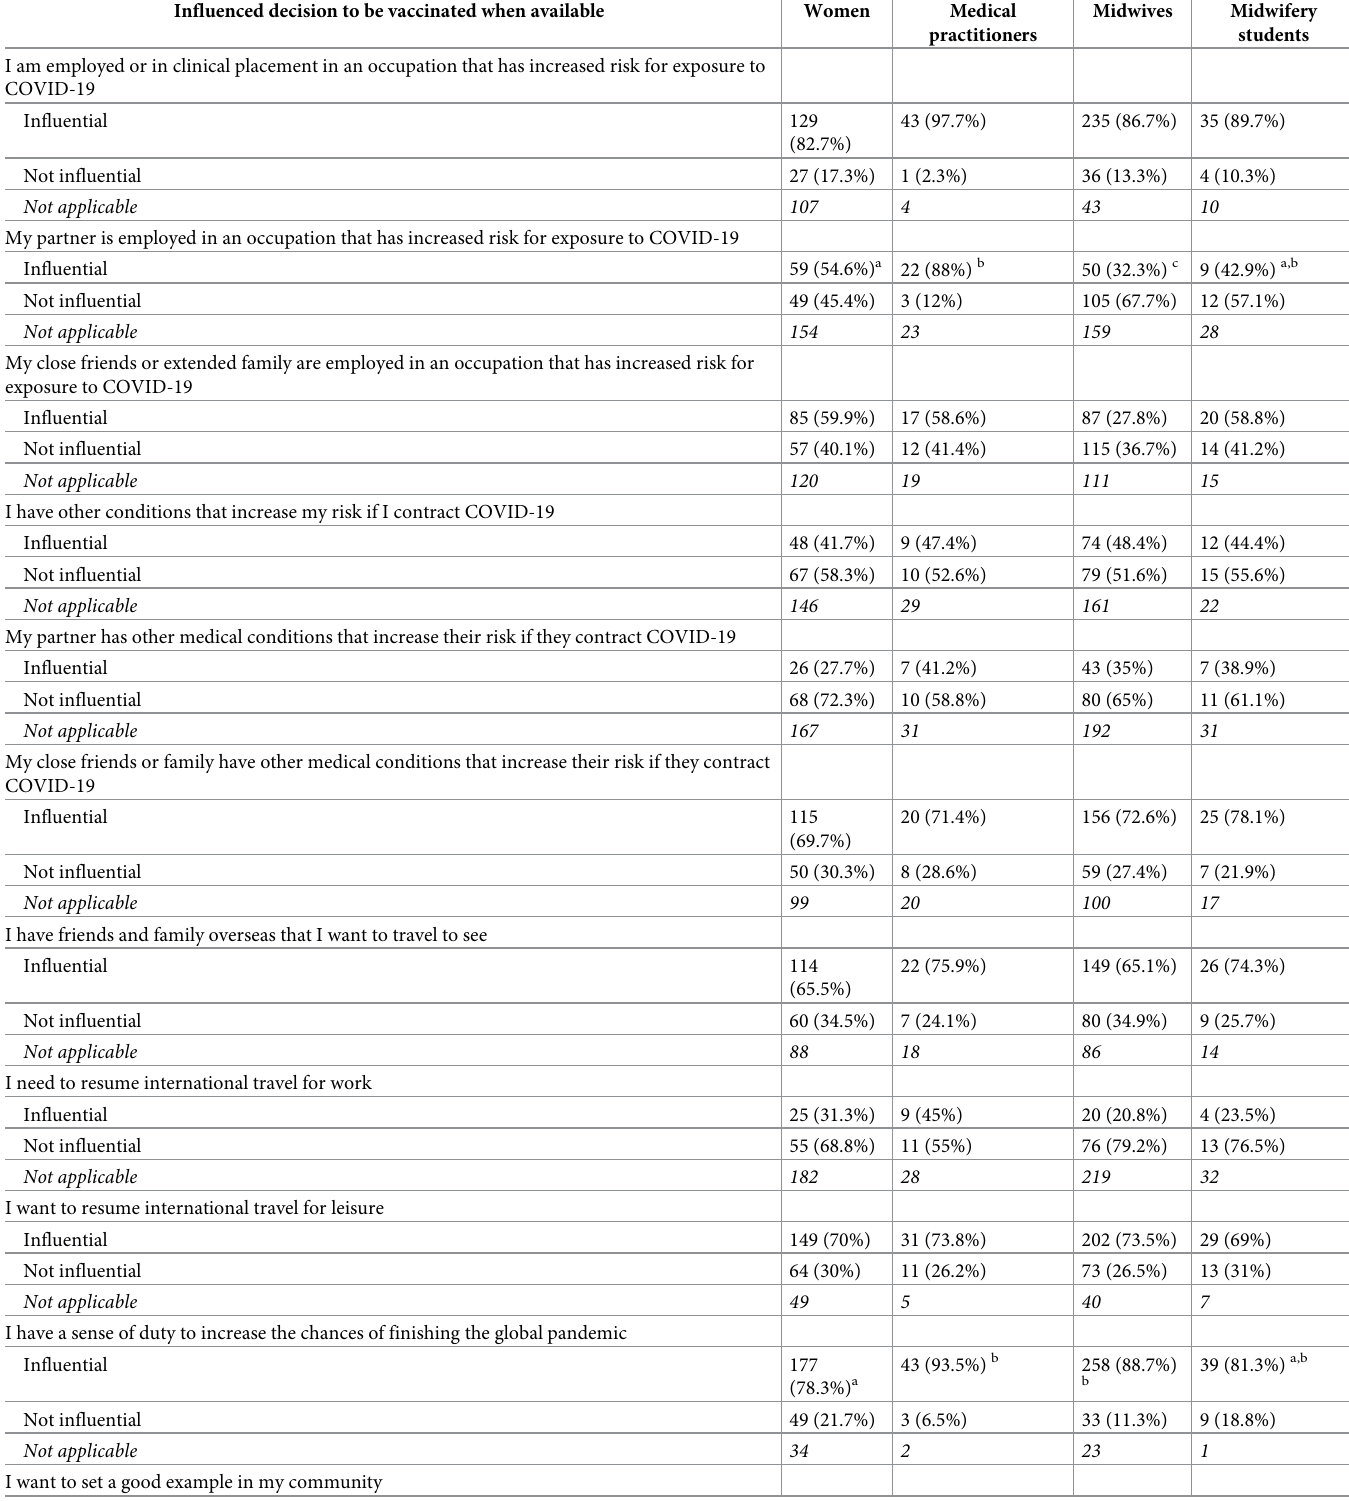
Table 6. Factors influencing decision to be vaccinated. Influenced decision to be vaccinated when